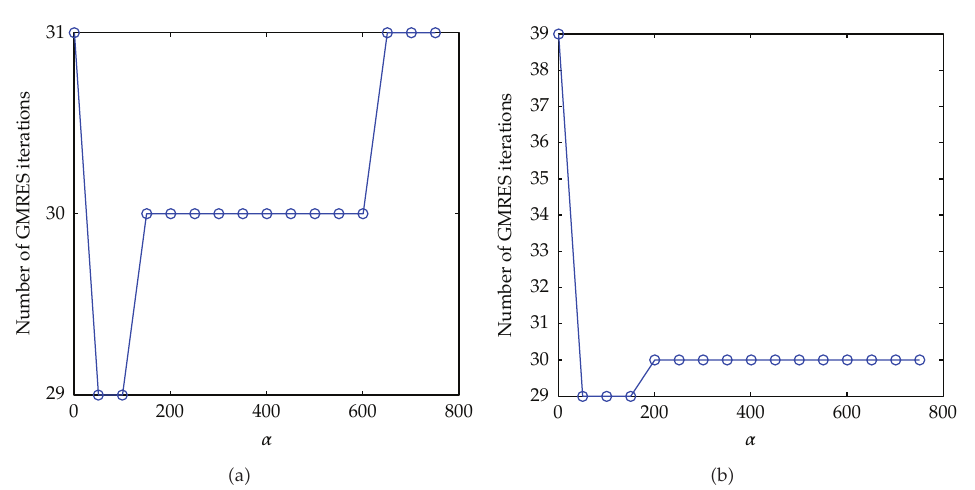
Figure 3: Iteration number versus parameter, steady Oseen problem, with υ (cid:6) 0 . 1. (cid:4) a (cid:5) 16 × 16 grid, (cid:4) b (cid:5) 32 × 32 grid.